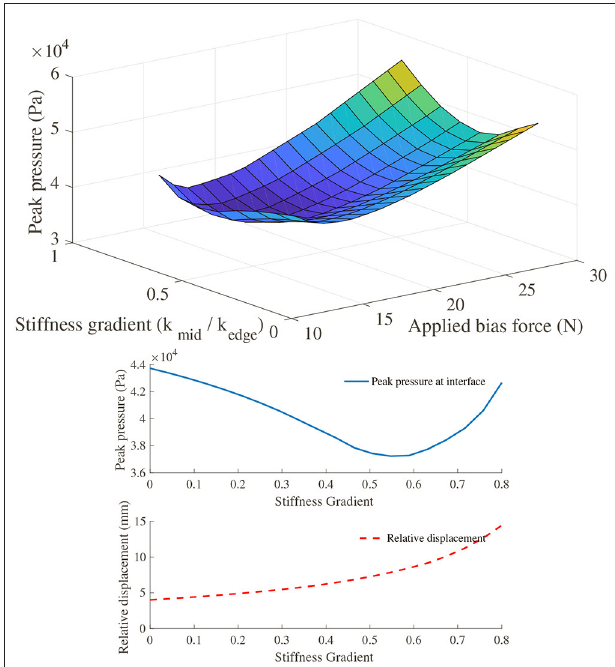
FIGURE 14 | (Top) Surface plot showing the effect of varying bias force and stiffness profiles on the peak pressure (as a measure of user comfort) across the PHRII on the hand dorsum. (Bottom) Trade-off between peak pressure (as a measure of user comfort) and relative displacement on varying the stiffness profile